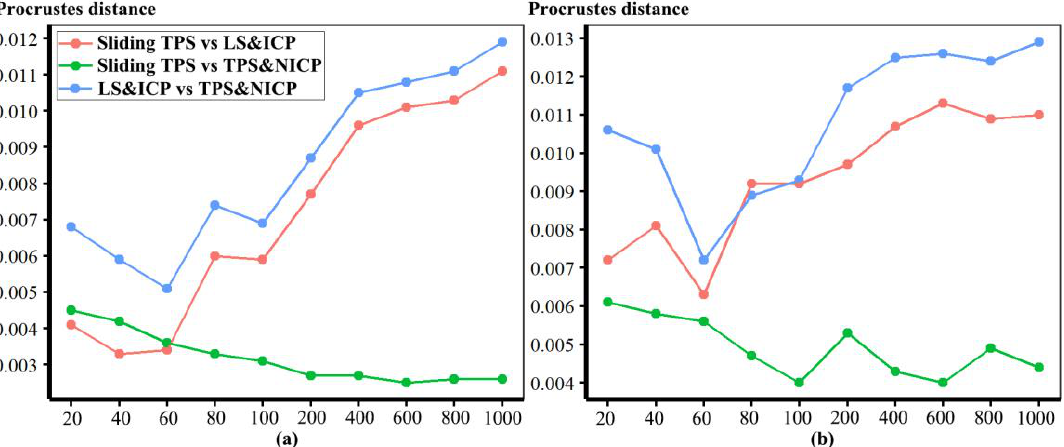
Figure 14. Procrustes distances computed between the vertices of human head surfaces, allometri- cally scaled to the maximum and minimum centroid sizes, based on different semilandmarking approaches after re-semilandmarking and re-warping the template mesh. ( a ) Maximum. ( b ) Mini- mum.